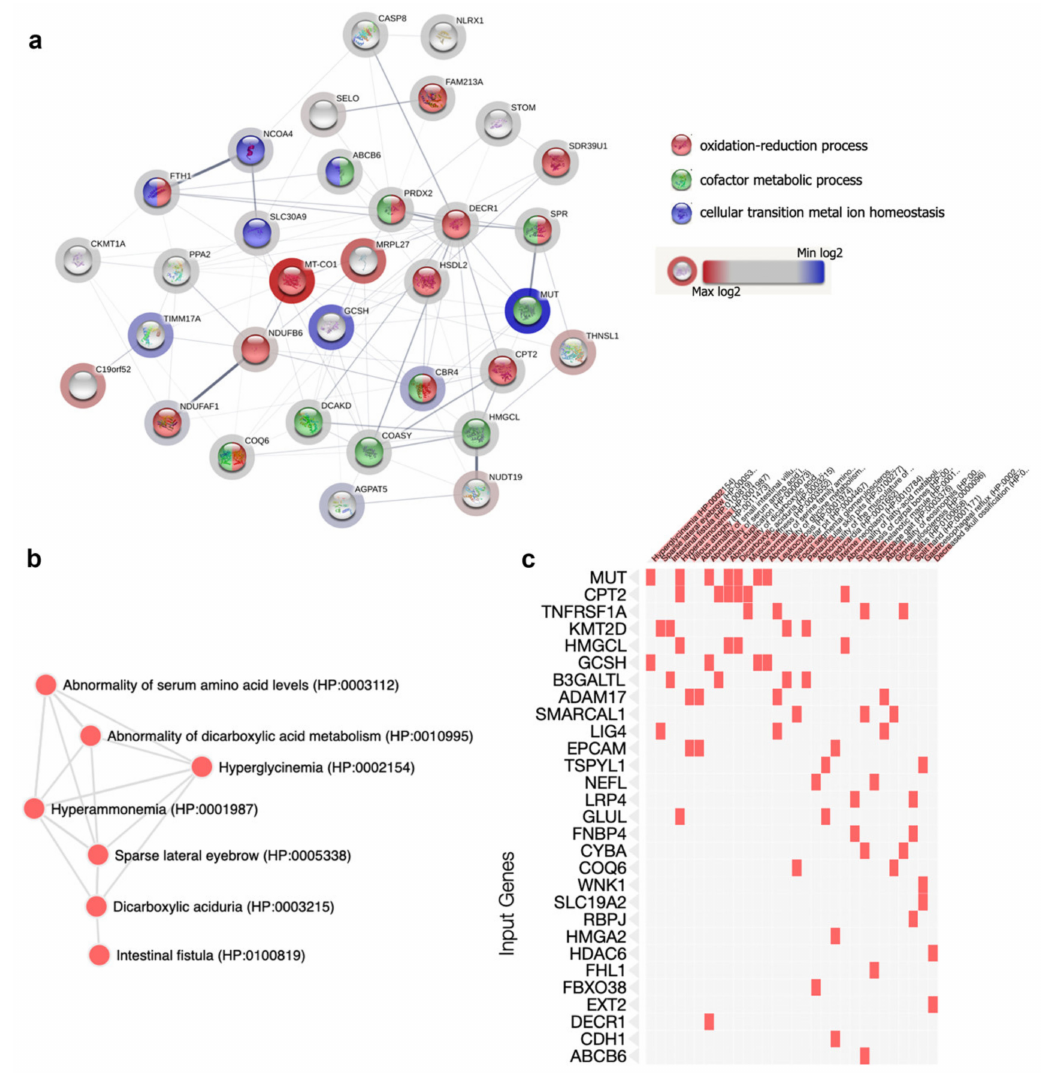
Figure 4. Bioinformatic enrichment of mitochondrial protein-protein interaction network and phenotypic abnormalities. ( a ) From the global list of di ff erentially regulated proteins, those belonging to mitochondria were analyzed by STRING in order to visualize their connections and the most significant processes. Nodes colour corresponds to the enriched categories. The halo around the node has a colour ranging from blue to red, which indicates the minimum and the maximum of the log2 di ff erence, respectively. Regulated proteins enriched ( b ) a network and ( c ) a cluster in which the most relevant phenotypic traits related to MMA emerged using the human phenotype